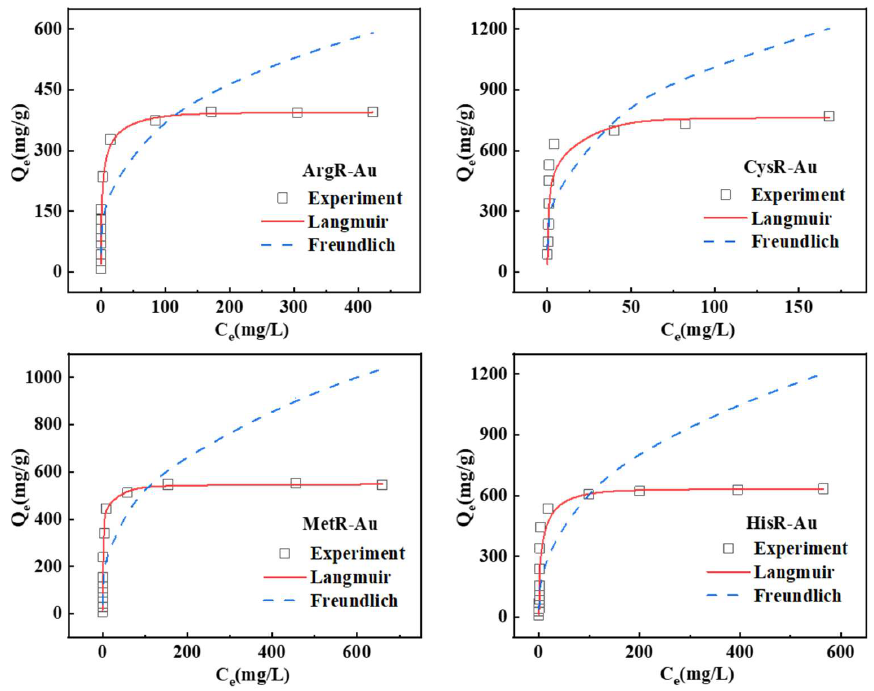
Figure 4. The adsorption isotherms for Au (III) by amino acid resins (adsorbent mass = 10 mg, volume = 10 mL, pH = 2, T = 30 °C, contact time = 24 h).